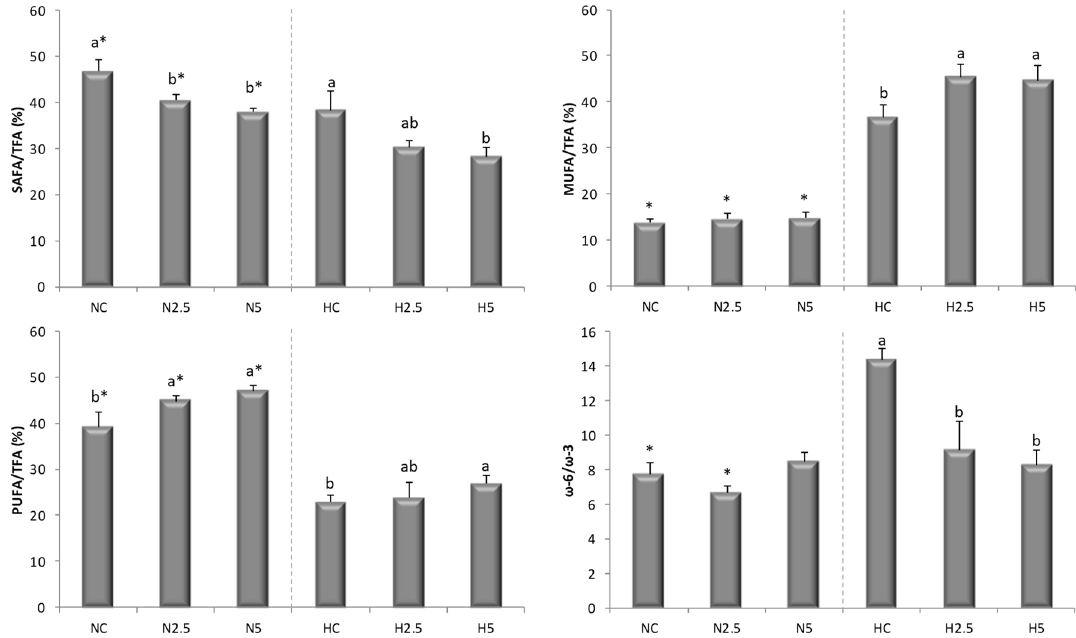
Figure 3. Saturated fatty acid (SAFA)/total fatty acid (TFA), monounsaturated fatty acid (MUFA)/TFA, polyunsaturated fatty acid (PUFA)/TFA, and ω -6/ ω -3 ratios in the liver of rats of the six experimental groups. a,b Different letters show significant statistical differences ( p < 0.05) among groups fed the standard diet (NC, N2.5, N5) or the high-fat diet (HC, H2.5, H5) after performing a one-way ANOVA. * Significant statistical difference ( p < 0.05), after carrying out a two-sample t test, between the members of the NC-HC, N2.5-H2.5, and N5-H5 pairings. Result are expressed as mean ± SD.